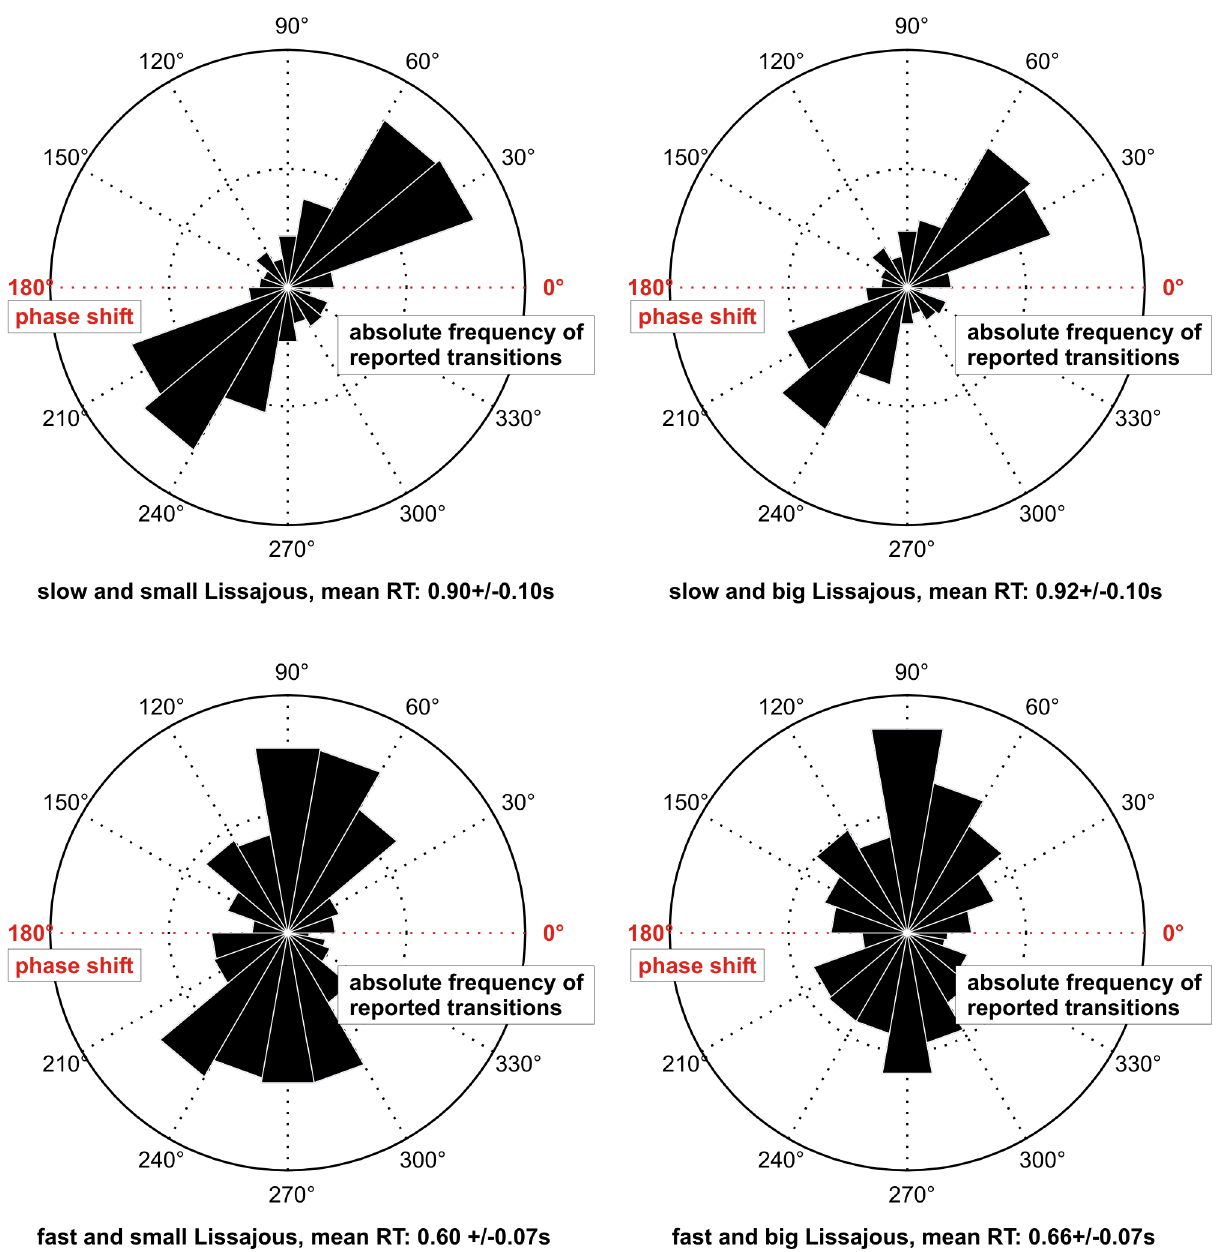
Fig 3. Distribution of button presses indicating perceptual transitions. Separately for all four conditions, transitions are plotted relative to the phase shift (i.e., degree of illusory rotation, 0 – 360°) of the Lissajous figure. The four panels show absolute frequencies of reported transitions across all participants. For the “ slow ” conditions (upper panels), the inner dashed circles of the polar plots denote 100, the outer circles denote 200. For the “ fast ” conditions (lower panels), the inner dashed circles of the polar plots denote 50, the outer circles denote 100. Self-occlusions of the Lissajous figure occurred at 0 and 180° (indicated by red color). Note that 10° of illusory rotation correspond to 0.2s in the “ slow ” and 0.1s in the “ fast ” conditions, leading to an increased offset between the self-occlusion positions and the distribution of transitions relative to degree of illusory rotation. Response times (RT) in all four conditions were calculated as the difference between the time points of button presses and the onsets of the preceding overlaps and are expressed as mean ± standard error of the